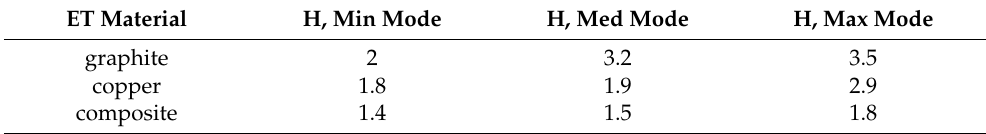
Figure 3. The unevenness of material removal during processing with three types of EI in the middle mode: ( a ) graphite ET, ( b ) copper ET, ( c ) composite ETI. Summary data for all processing modes for dissimilar electrodes are shown in Table 4. Table 4. Uneven material removal during processing with heterogeneous EI in three modes, H,